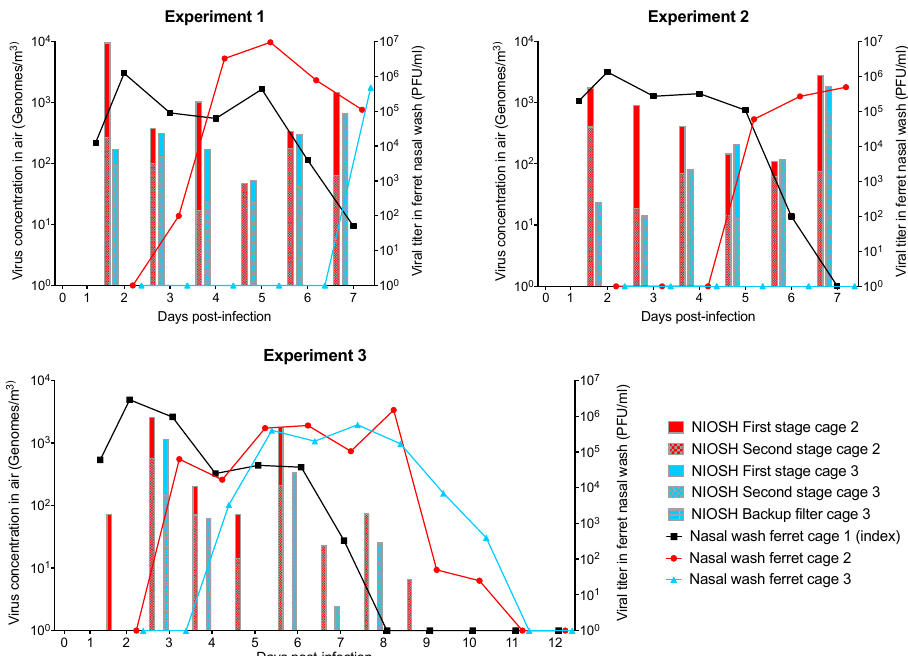
Figure 7. Influenza genome per cubic meter of air, and influenza virus titer in nasal washes of ferrets hosted in cage system for 7 or 12 days from three experiments. The index ferret (cage one) was infected on day 0. Air samples were collected using National Institute for Occupational Safety and Health (NIOSH) two-stage bioaerosol cyclone samplers. Genome concentrations found with the NIOSH first stage, second stage and backup filter are superimposed.